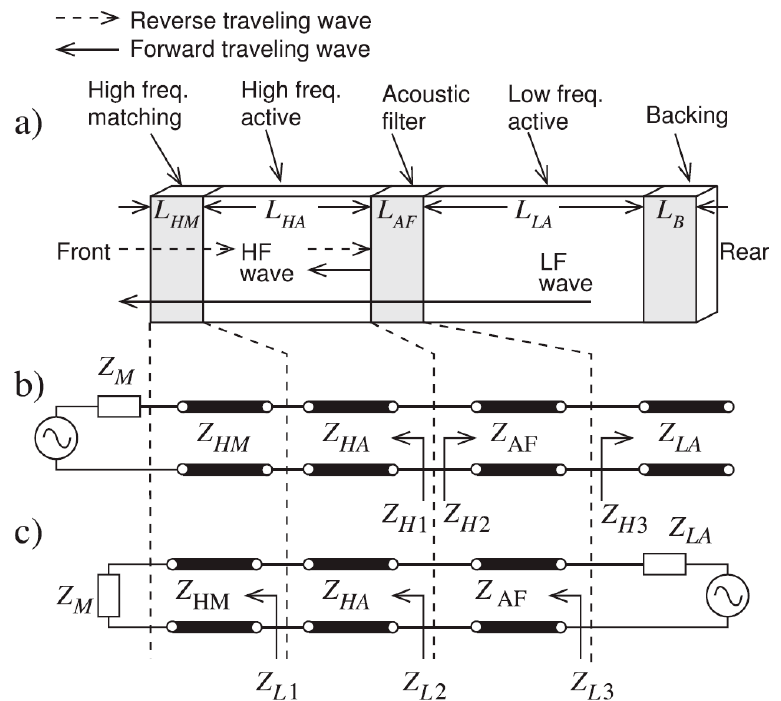
Figure 7. Schematic of piezoelectric cascaded structure and its equivalent circuit with the ability of ( a ) dual-frequency filter design, ( b ) high-frequency reception, and ( c ) low-frequency transmission. Reprinted from [190], with the permission of AIP Publishing.